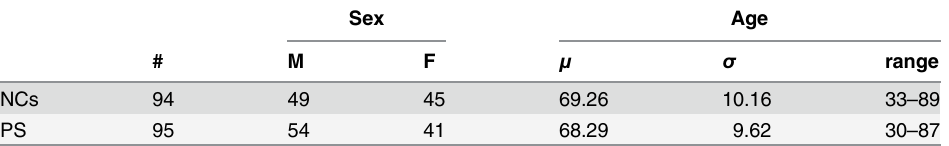
Table 1. Demographic details of the subjects who participated in this study. μ and σ stand for the aver- age and the standard deviation